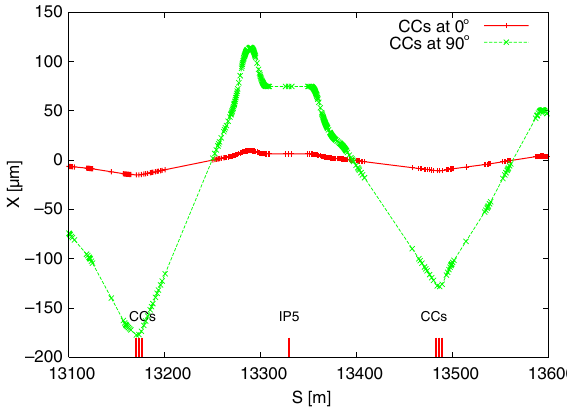
FIG. 1. Effect of the CCs on the X orbit of a particle at 0 . 133 σ z ( 1 σ z ¼ 75 . 5 mm) longitudinal position when the CC phases are 0° and 90° around IP5. According to Eq. (1) the kick is small when the CC phase is 0° (red) and becomes significant close to 9 σ 1 σ ¼ 8 . 7 μ m) at IP when the CC phase is 90° x ( x